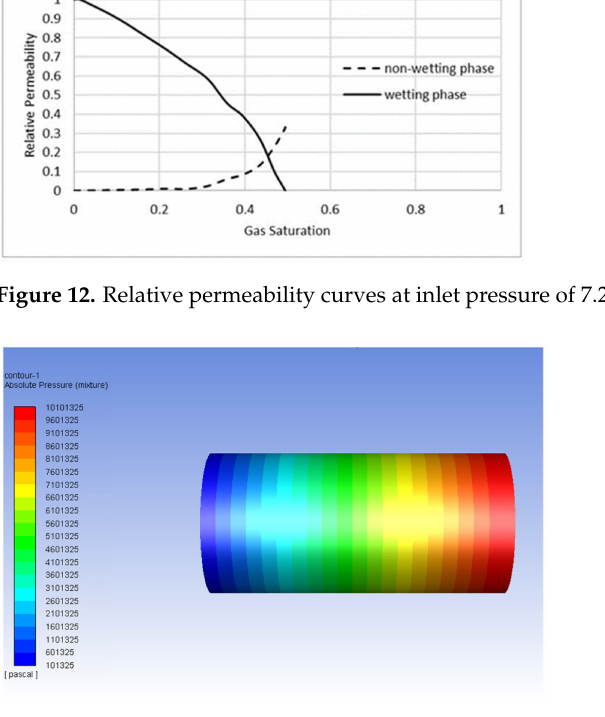
Figure 13. Pressure profile across the core—supercritical carbon dioxide inlet pressure 10.1